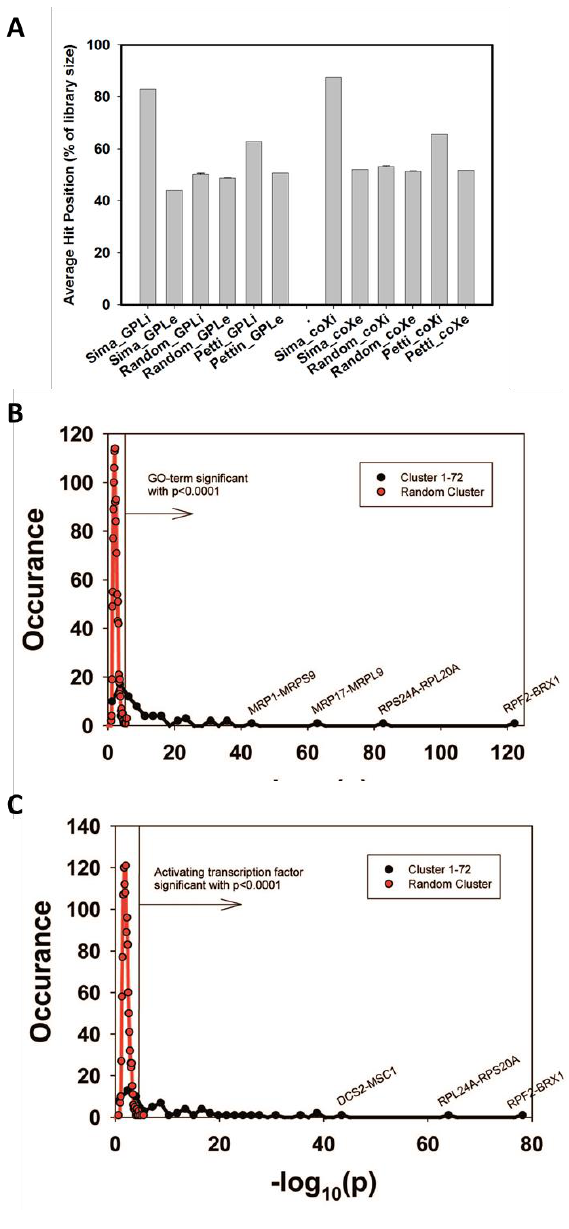
FIGURE 1: Evaluation of Genome-wide expression cliques. (A) Comparison between our clique set, random genes and the clique set from Petti et al . The comparison is based either on our own co- expression database (left side) or on the co-expression database from COXPRESdb (right side). (B) GO-term assignments for the 72 identified cliques or for random cliques. The significance threshold for p<0.0001 is indicated as vertical line in the figure. As compari- son to the calculated cliques (red plot) random gene cliques were used (black plot). (C) Assignment of activating TFs for the identified 72 cliques or for random cliques based on the YEASTRACT data- base. The significance threshold for p<0.0001 is indicated as verti- cal line in the